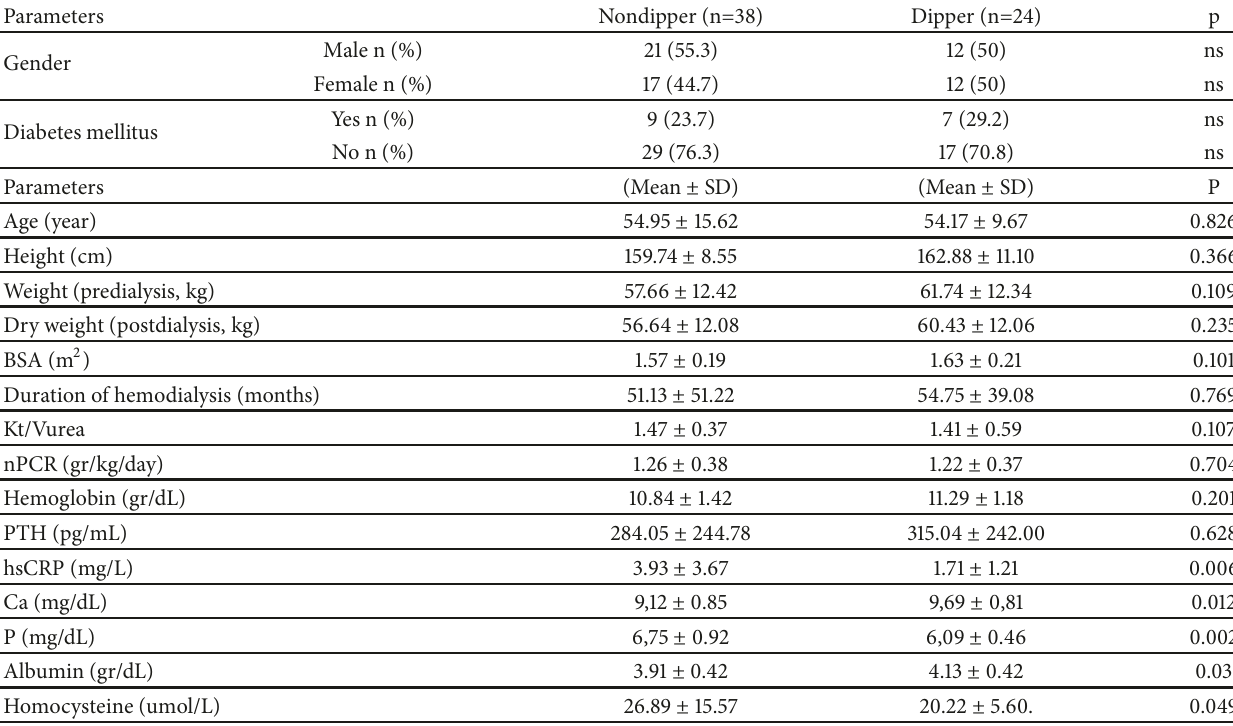
Table 1: Basic patient demographic characteristics and laboratory data.